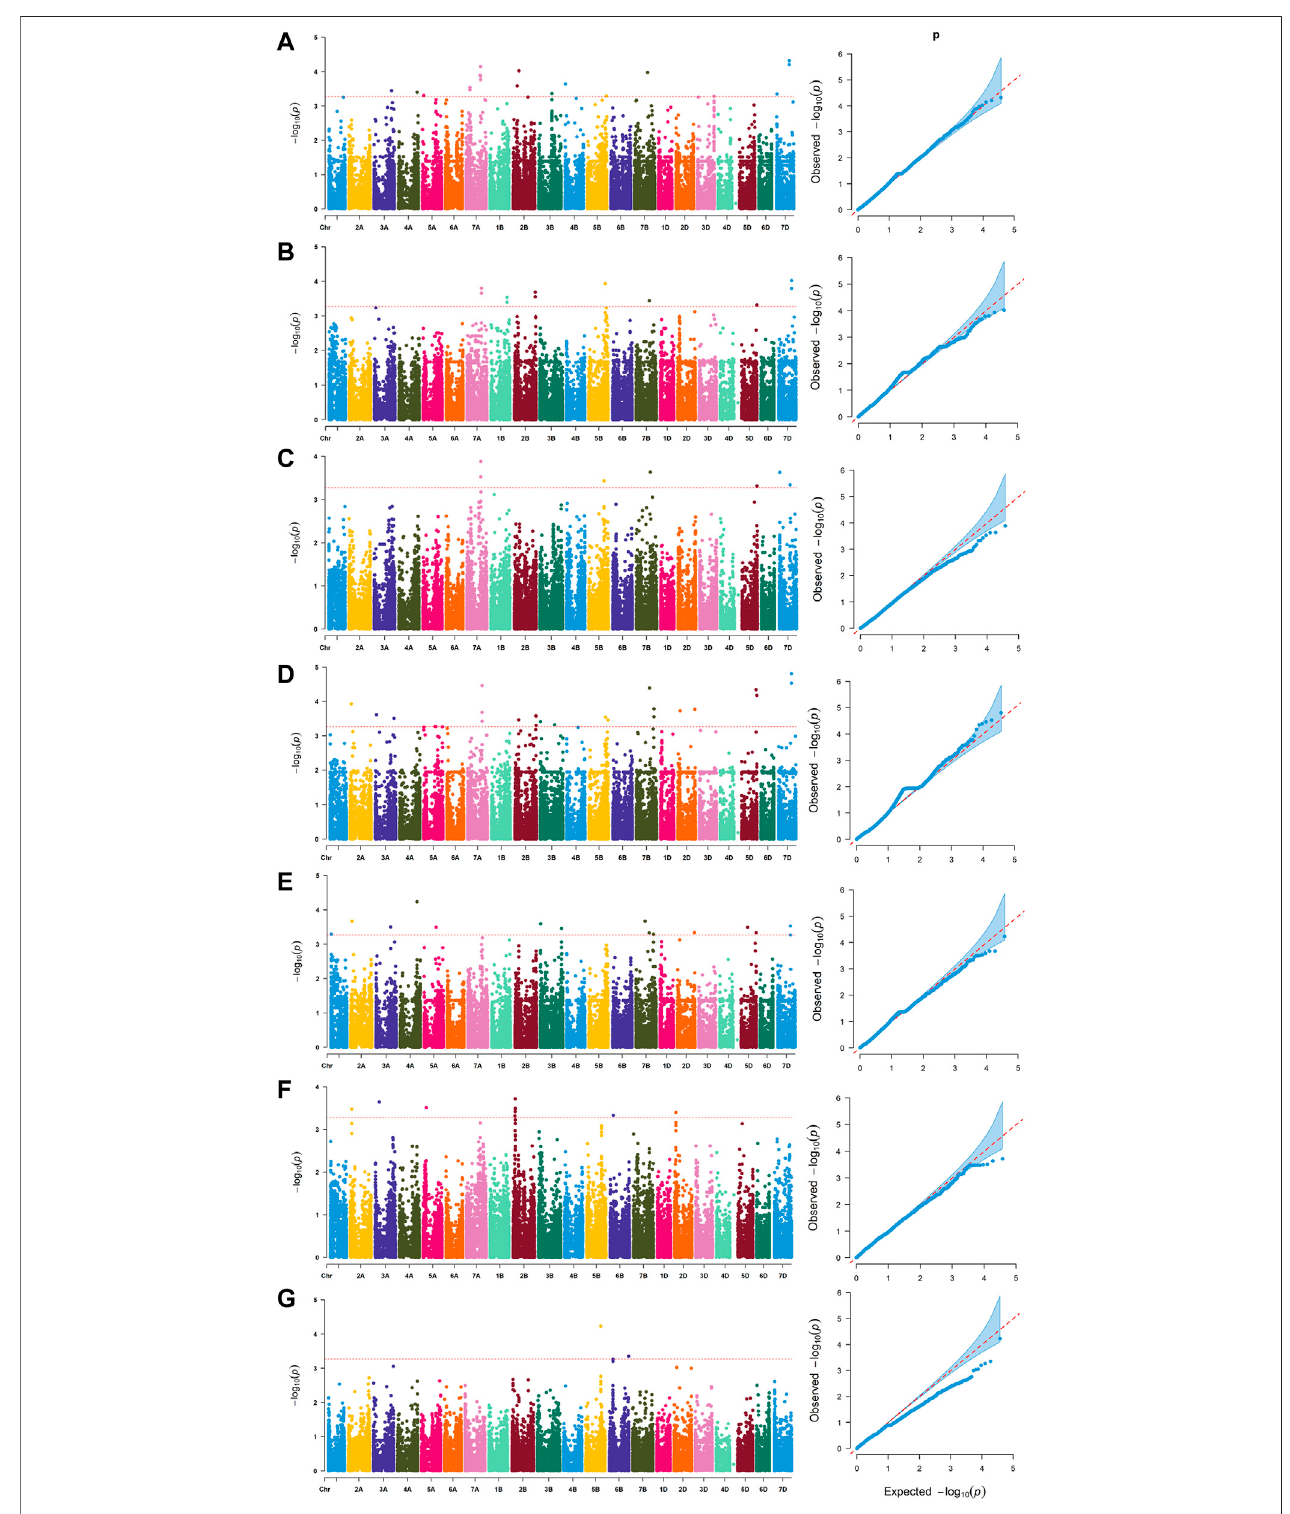
FIGURE 2 | Manhattan and quantile-quantile (Q – Q) plots for RVA parameters identi fi ed by genome-wide association study based on BLUP values. (A) peak viscosity (PV). (B) trough viscosity (TV). (C) breakdown (BD). (D) fi nal viscosity (FV). (E) setback (SB). (F) peak time (PT). (G) pasting temperature (T).